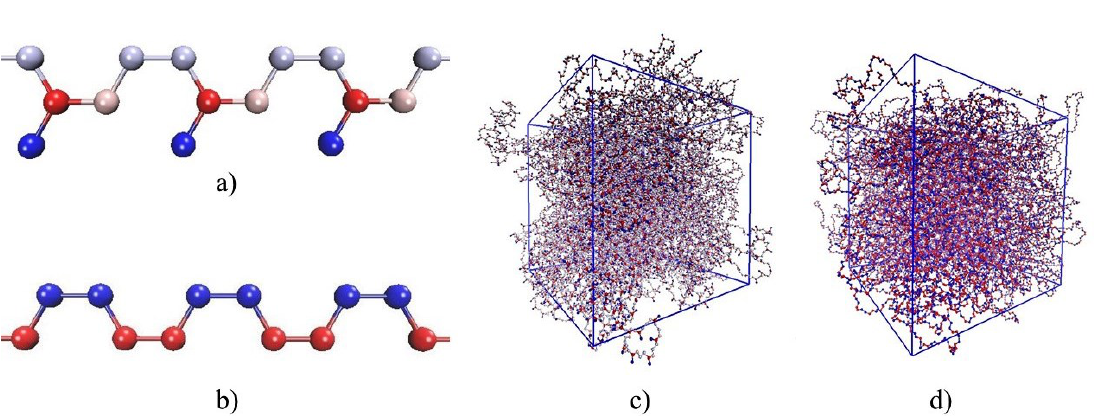
Figure 1. Models of polymeric systems: ( a ) fragment of cis -1,4-polyisoprene chain: C atom (red), CH group (pink), CH 2 group (grey), CH 3 group (blue); ( b ) fragment of cis -1,4-polybutadiene chain: CH group (blue), CH 2 group (red); ( c ) 27 chains of polyisoprene in periodic supercell; ( d ) 27 chains of polybutadiene in periodic